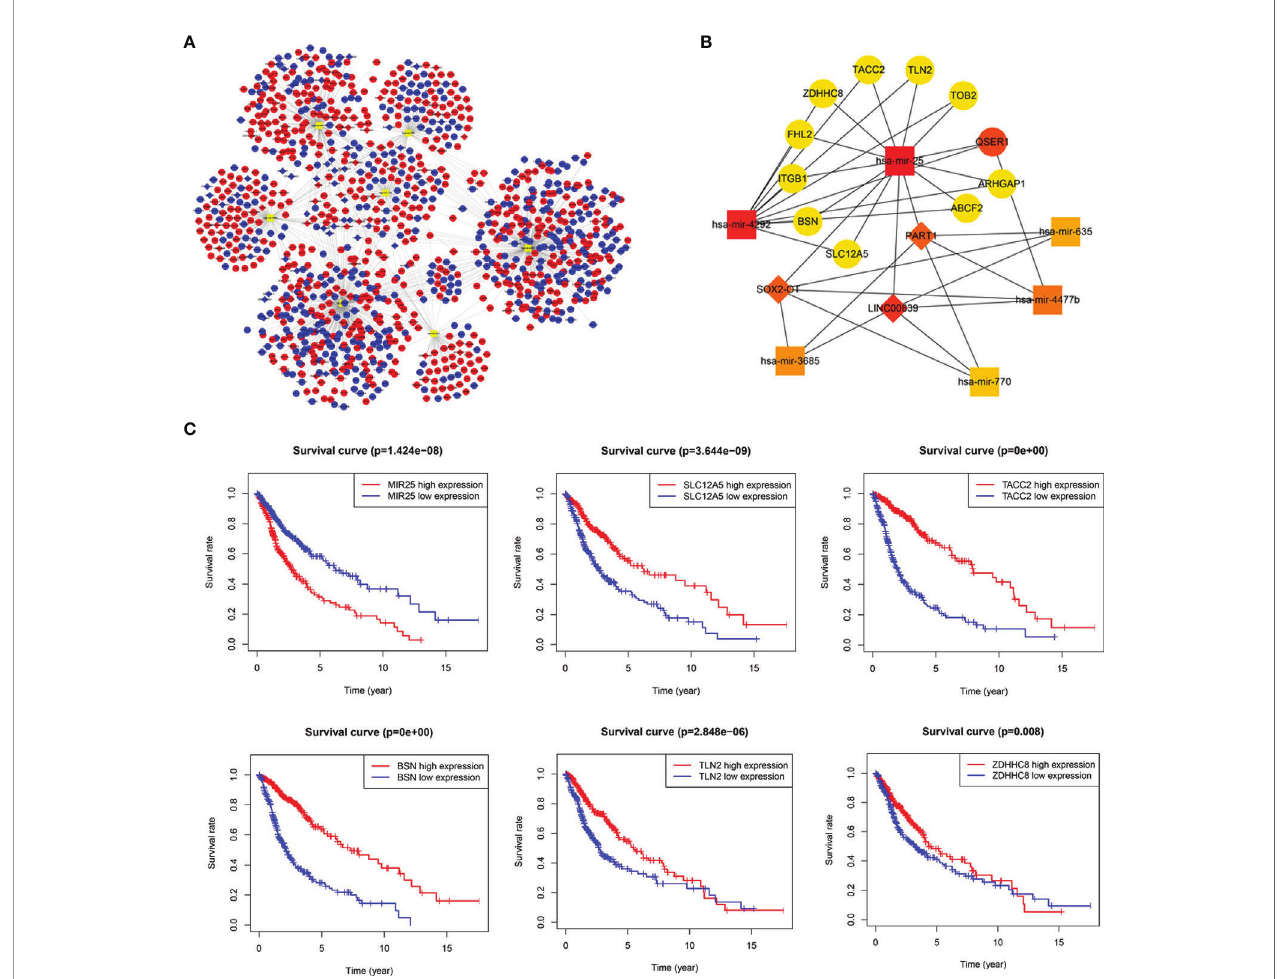
FIGURE 2 | Long noncoding RNA (lncRNA)-prognostic microRNA (miRNA)-mRNA competing endogenous RNA (ceRNA) network in glioma. (A) Overview of the ceRNA network in glioma. Red and blue diamonds represent upregulated and downregulated lncRNAs, respectively. Red and blue circles represent upregulated and downregulated mRNAs, respectively. Orange rounded rectangles represent microRNAs. (B) Key sub-network of the ceRNA network. (C) Survival curves for miR-25 and its targets (SLC12A5, TACC2, BSN, TLN2, and